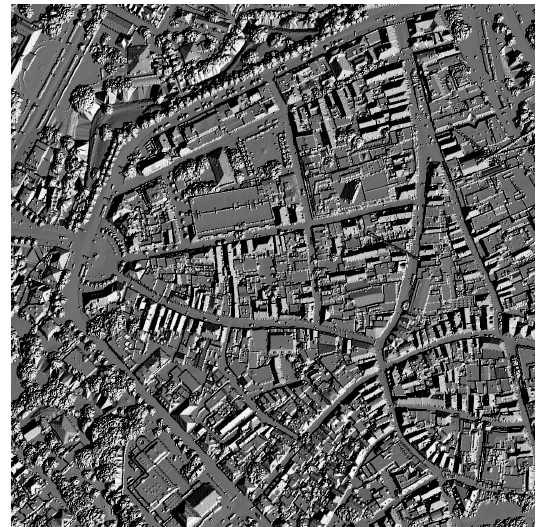
Figure 3: A 500 m x 500 m subset of the shaded relief digital surface model derived from a Riegl LMS Q560 airborne laser scanner of Oldenburg.